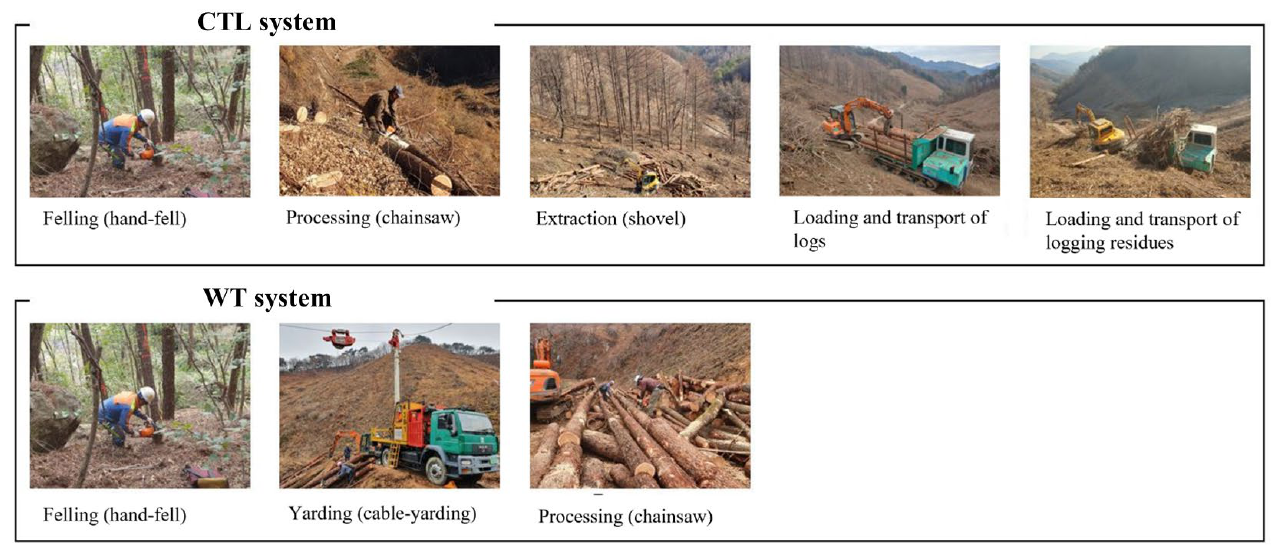
Figure 2. Description of the integrated harvesting systems used in the forest of the National Forestry Cooperative Federation. Table 1. Specifications of the harvesting equipment used in the CTL and WT